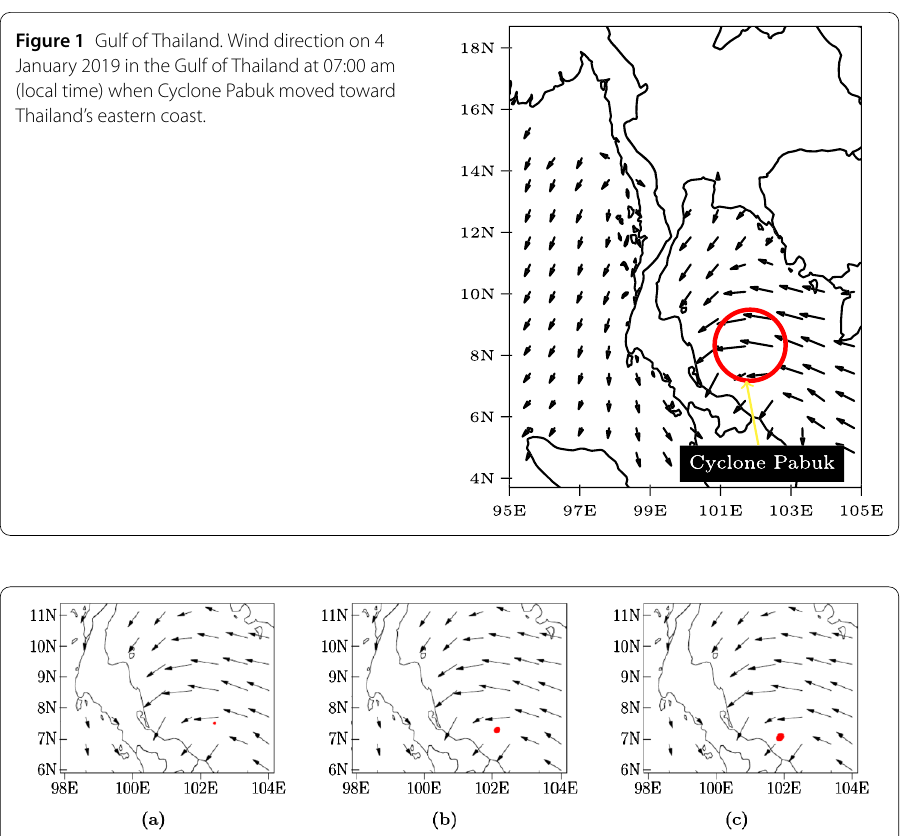
Figure 2 Movement of oil at Bongkot 5. The movement of oil slick (red dots in elliptical shape) at South Bongkot 5 oil drilling rig. ( a ) at the beginning of incident, ( b ) 30 minutes later, and ( c ) 60 minutes later.